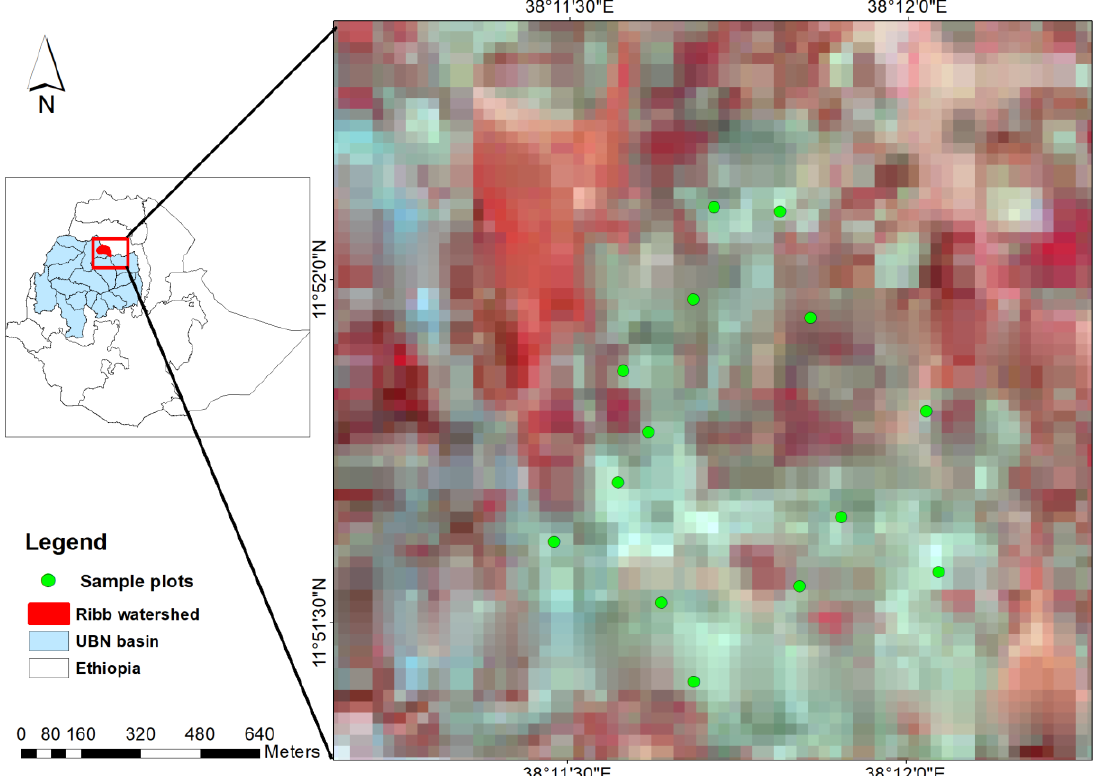
Figure 1. Location map of the study area (background with Land sat satellite imagery) located in the Ribb Watershed of the Upper Blue Nile (UBN) Basin, Ethiopia.